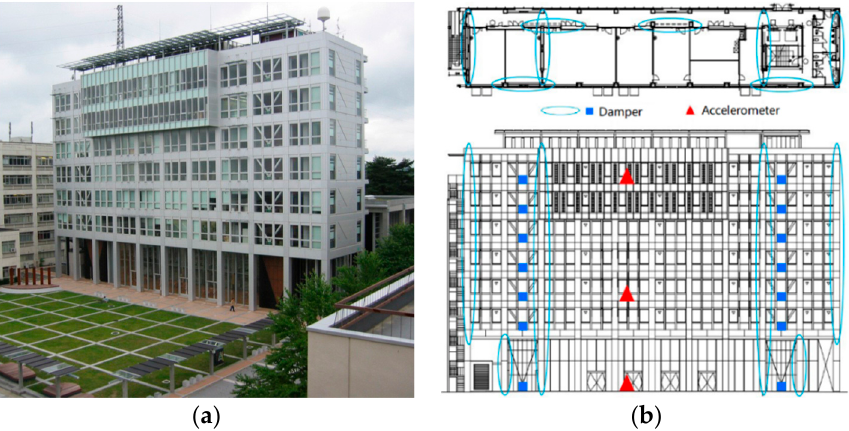
Figure 1. The administration building: ( a ) front view; ( b ) allocation of oil dampers and accelerometers.